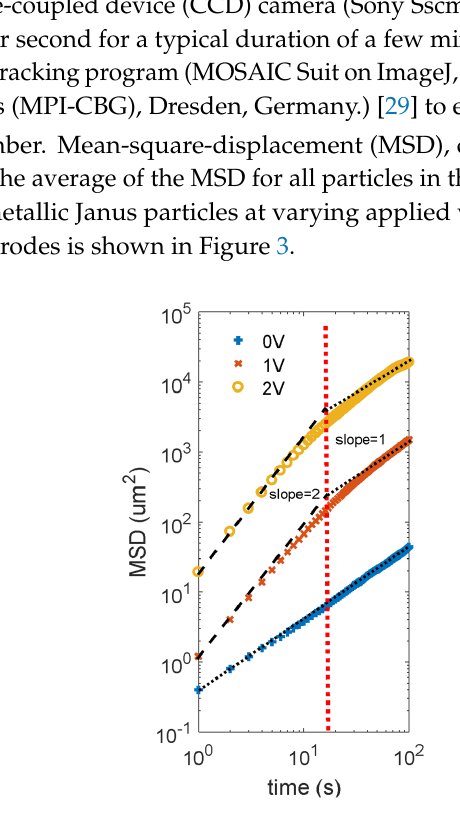
Figure 3. Mean-squared-displacement (MSD) of ICEP-driven metallic Janus particle under 5 kHz AC electric field. The extrapolated dash lines are from ballistic motion (the slope of 2) to the active di ff usive motion (the slope of 1). The red vertical dotted line represents the particle’s rotational relaxation